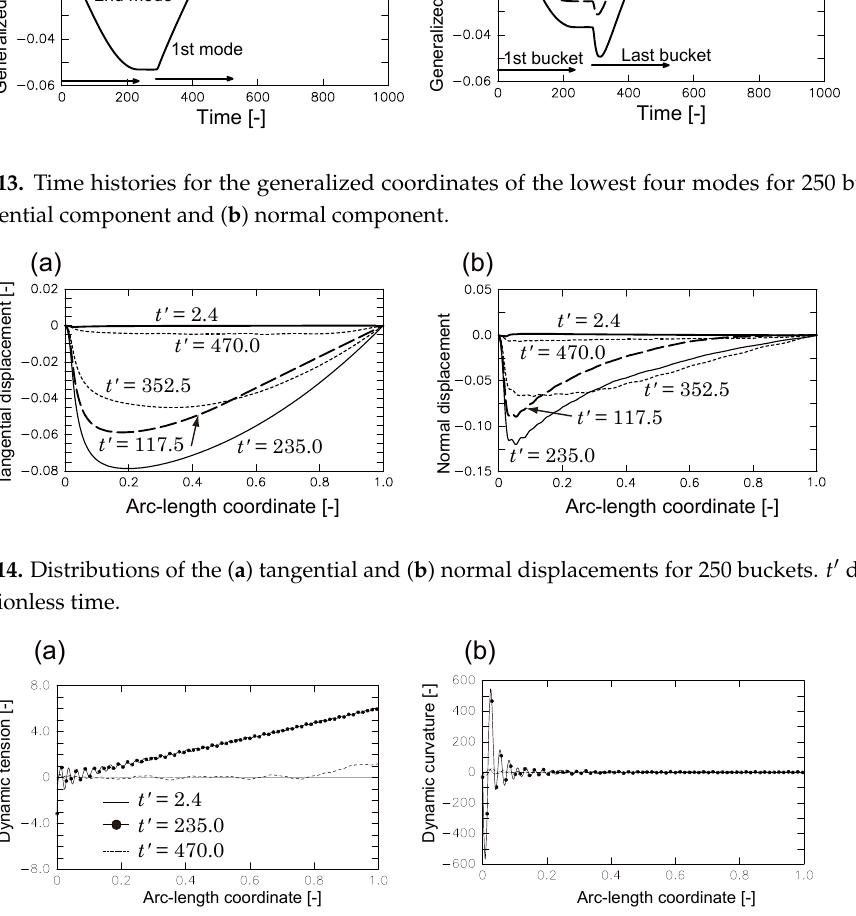
Figure 15. Distributions of the ( a ) dynamic tension and ( b ) dynamic curvature for 250 buckets. t (cid:48) denotes dimensionless